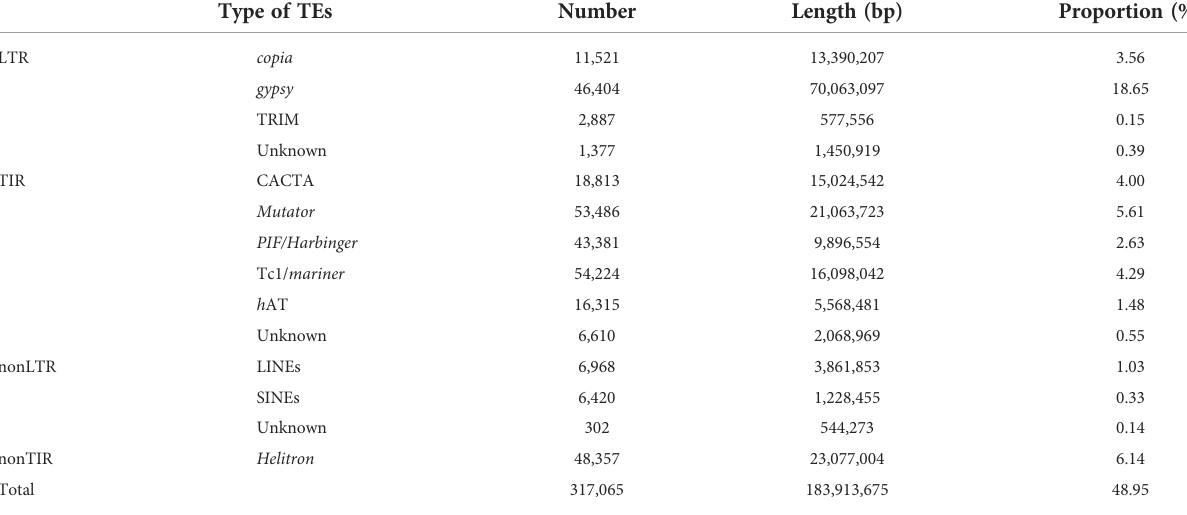
TABLE 2 The statistics of transposable elements annotation results in